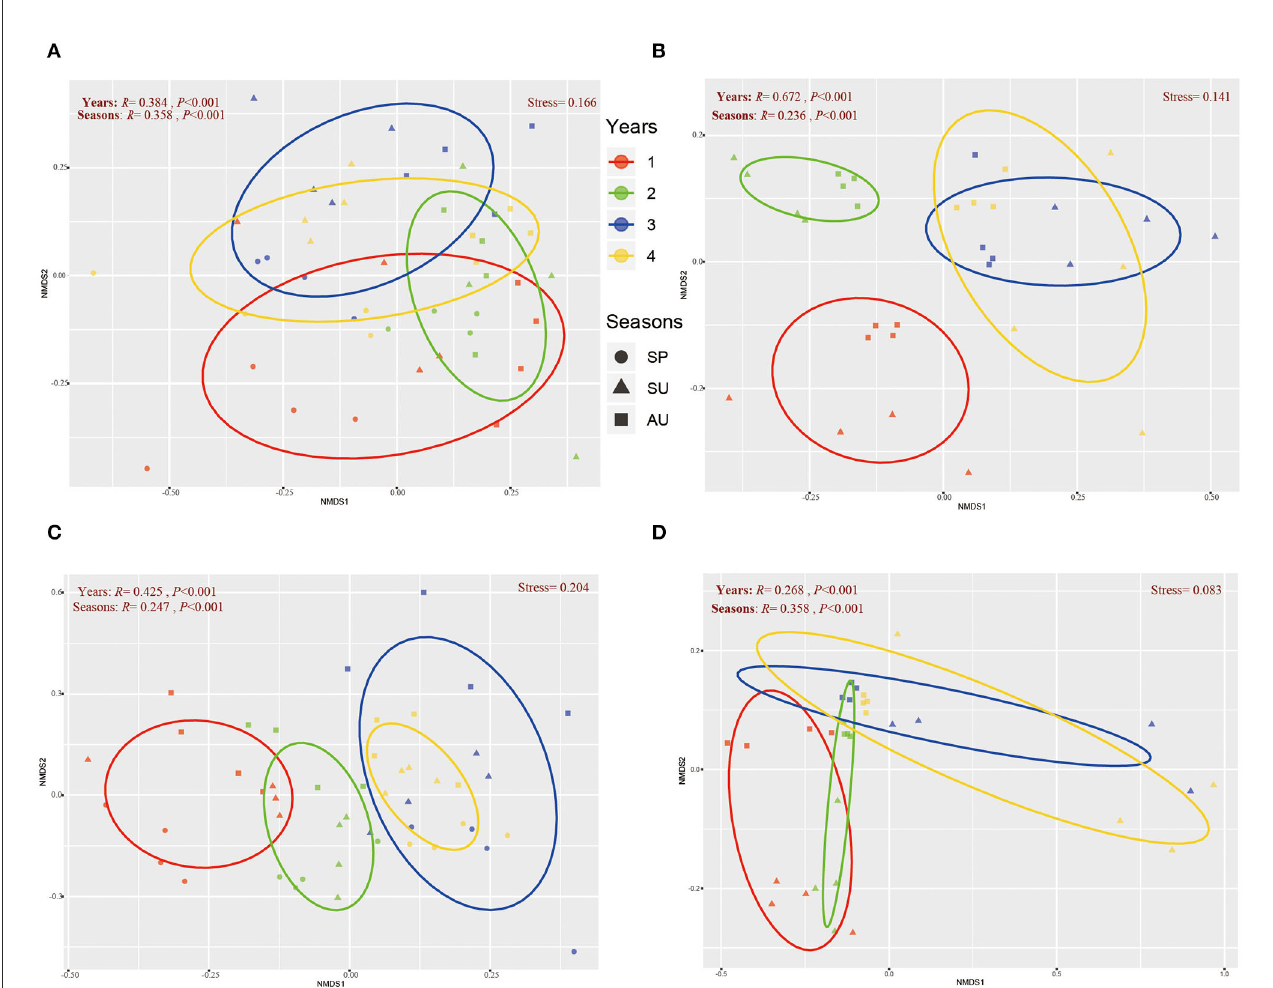
FIGURE3 The general pattern of microbial beta-diversity in the soil of three seasons during four years. NMDS showed the structure of the bacterial community of Site I (A) and Site II (B) , and the fungal community of Site I (C) and Site II (D) . Similarity values among the samples of different seasons (“Seasons”) during 1- to 4-year (“Years”) were examined via the ANOSIM test, which are shown in each plot. 60% confidence ellipses were shown around the samples grouped based on different ages of American ginseng